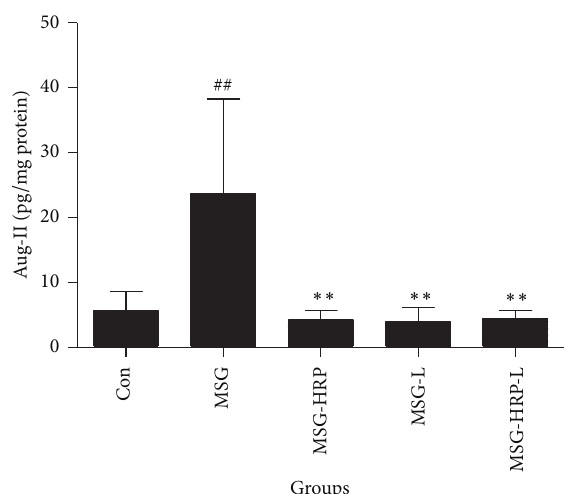
Figure 5: Levels of pancreas local Ang-II. Local Ang-II was obvi- ously increased in the MSG group compared with the Con